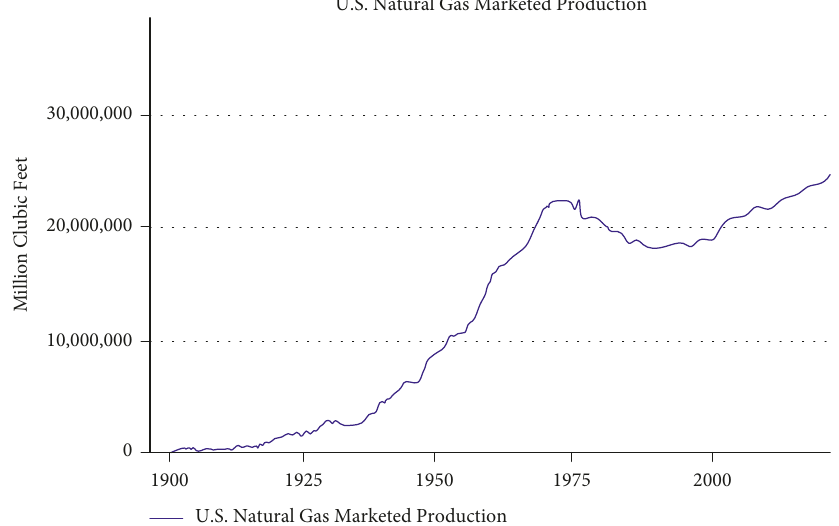
Figure 1: An example of a gas market.